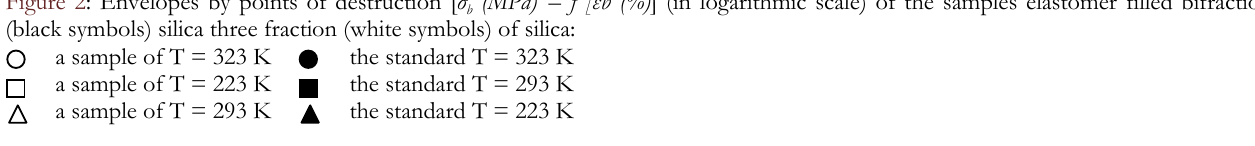
(MPa) = f [ ε b (%) ] (in logarithmic scale) of the samples elastomer filled bifraction b